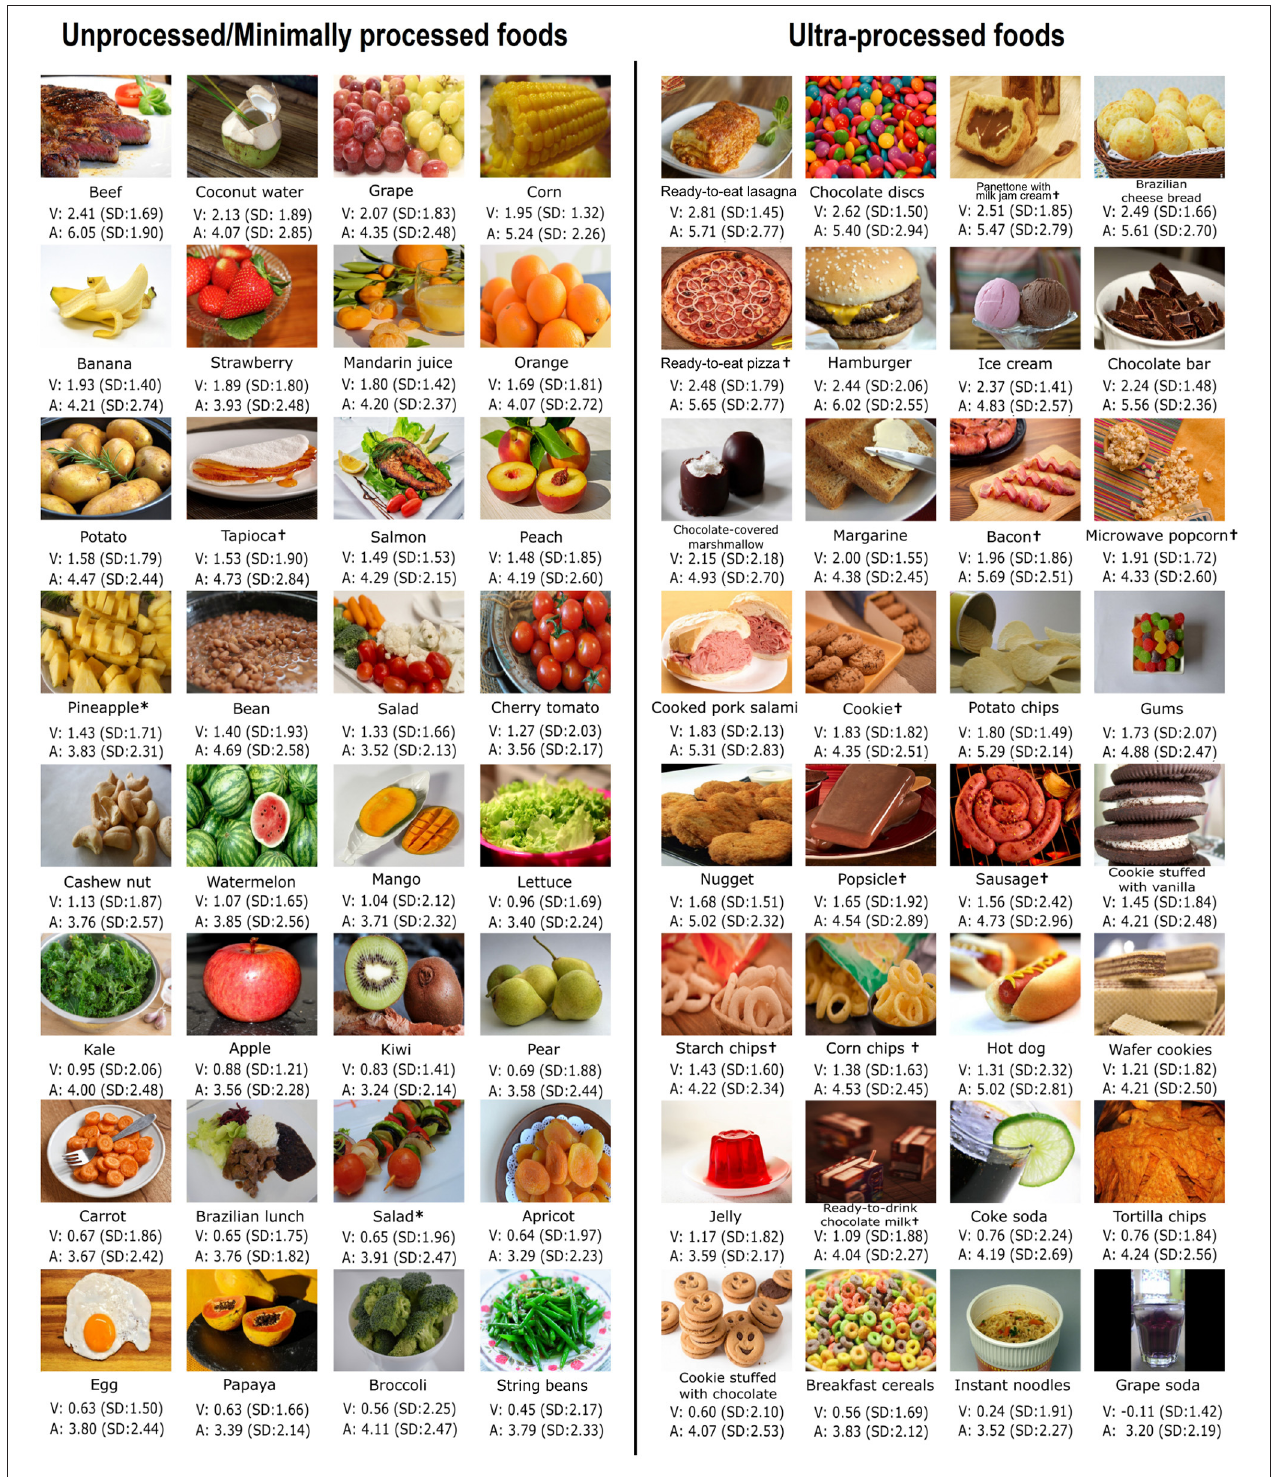
FIGURE 3 | Pictures of the UMPF and UPF presented in the study. The mean and SD values of pleasantness (hedonic valence; V) and arousal (A) are indicated below each picture. Pleasantness ratings ranged from − 4 (extremely unpleasant) to + 4 (extremely pleasant) with 0 indicating neutrality. Arousal ratings ranged from 1 (very low arousal) to 9 (extremely arousing). The pictures with asterisks in the UMPF group (fru_5772–pineapple and veg_0092–salad) belong to the Open Library of Affective Foods (45). Pictures with the symbol † were produced by the commercial photographer Alexander Chiacchio. UMPF, unprocessed/minimally processed foods; UPF, ultra-processed foods; SD, standard